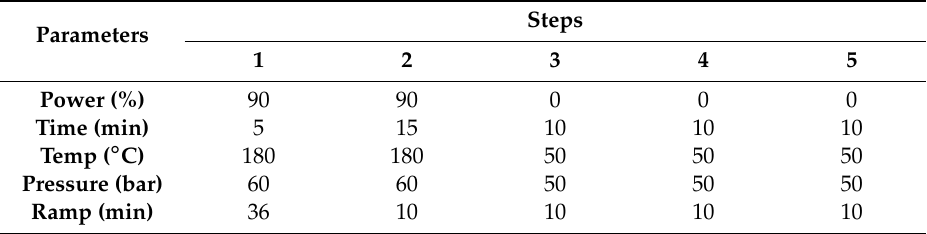
Table 1. Microwave digestion program for the digestion of henna and walnut tree bark samples. Parameters